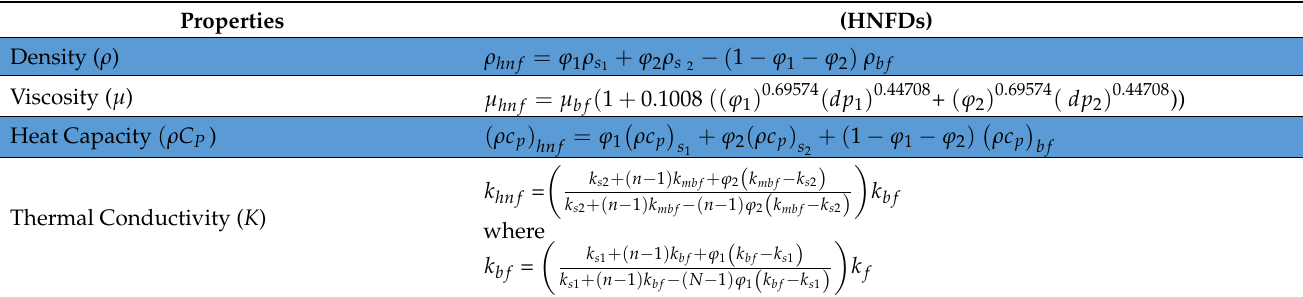
Table 1. Thermophysical properties of hybrid nanofluid [51].